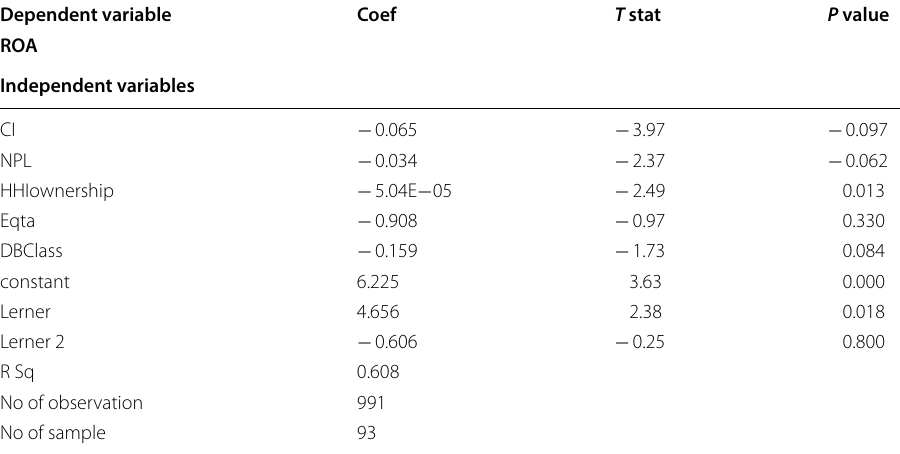
Table 9 Regression result for Lerner index and profitably relationship. Source: Author’s calculation on data provided by the Indonesia Financial Services